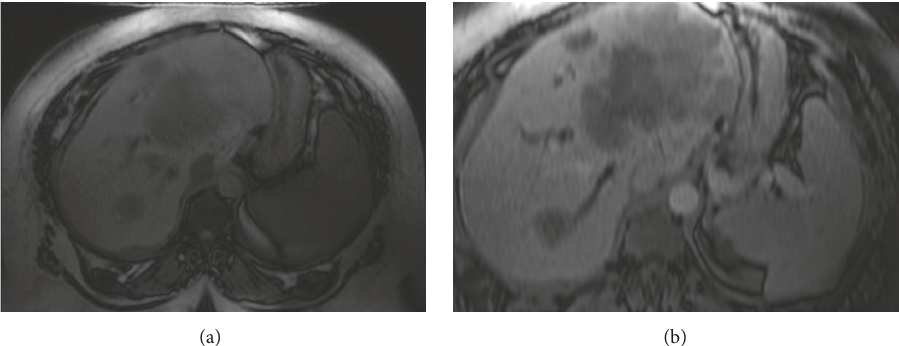
Figure 2: MRI of the liver and abdomen showing the large hepatic mass. (a) T1-weighted image. (b) T2-weighted image. The mass is involving the majority of the left hepatic lobe, measuring approximately 11.2 × 9.2 × 5.8 cm. There are multiple additional satellite lesions within the left hepatic lobe. There is an additional similar-appearing smaller T2 hyperintense lesion within the right hepatic lobe, measuring approximately 2.8 ×